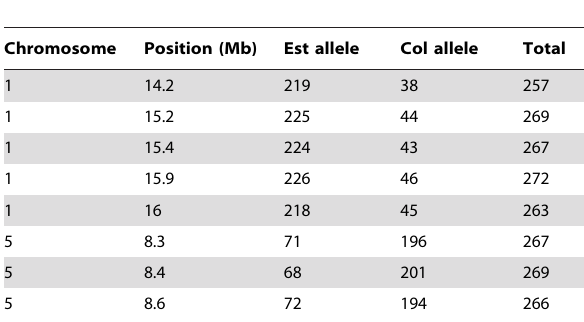
Table 1. Distribution of genotypes at markers on chromosomes 1 and 5 in the EstC AI-RIL population.